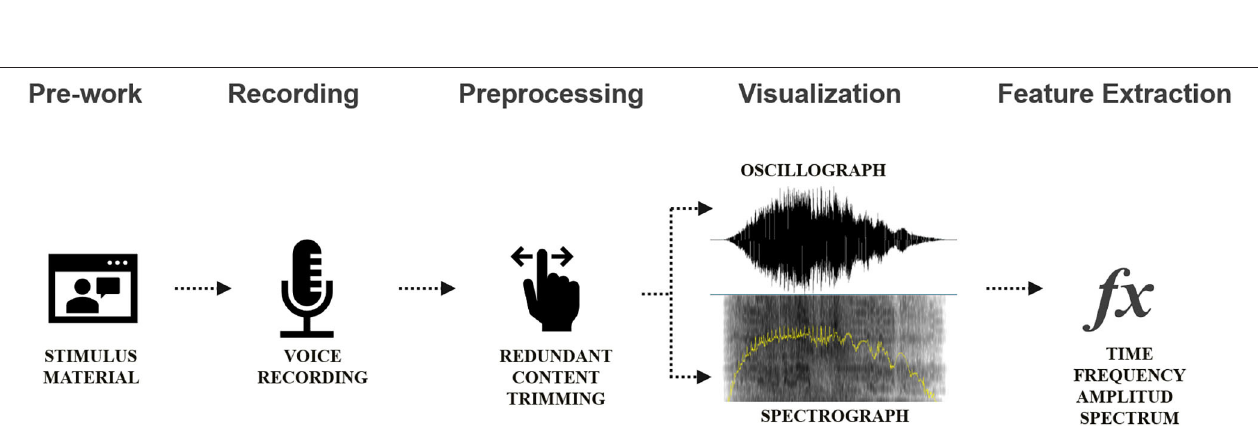
FIGURE 3 | Data collection procedure. Source: drawn by the